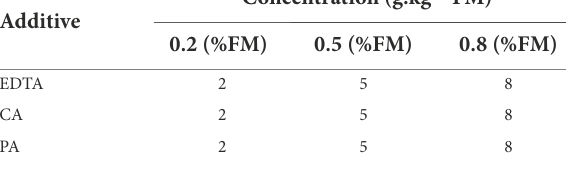
TABLE 1 Concentration of different additives added to paper mulberry